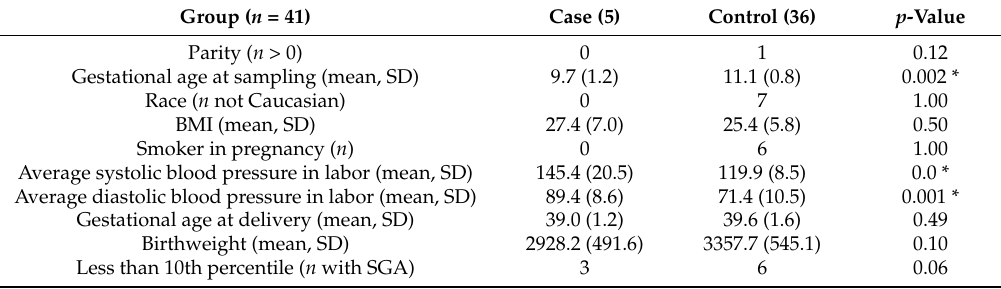
Table 4. Study groups.